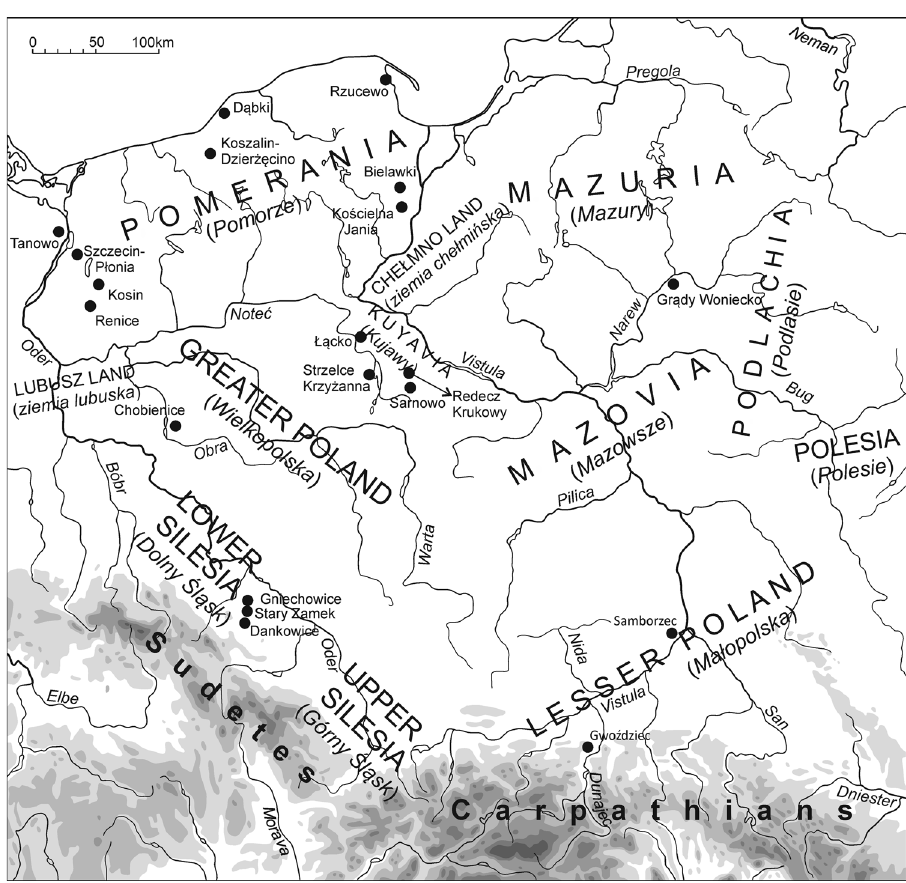
Figure 1: The location of the study area with basic historical regions and archaeological sites mentioned in the text and fi